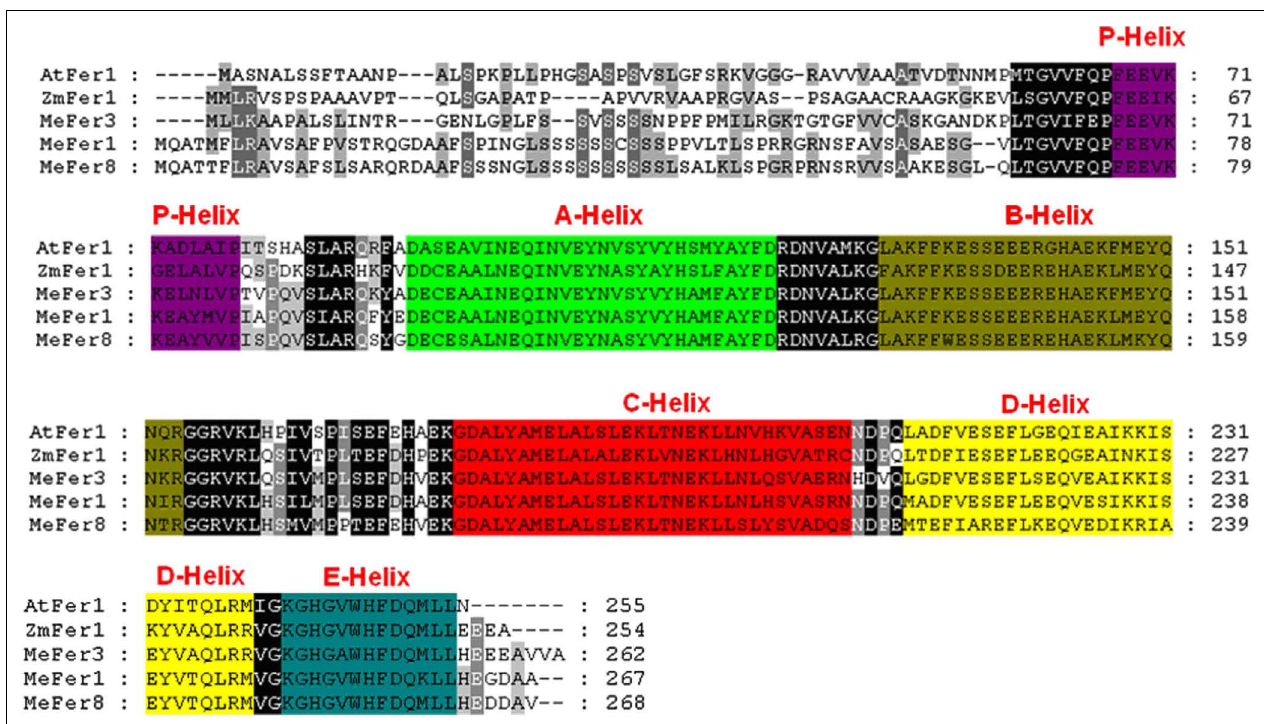
Different helixes of ferritin protein are shaded as indicated. Species designations are as follows: At, A. thaliana (AtFER1); Zm, Zea Mays (ZmFER1); Me, Mannihot esculenta (MeFER1, MeFER3, and